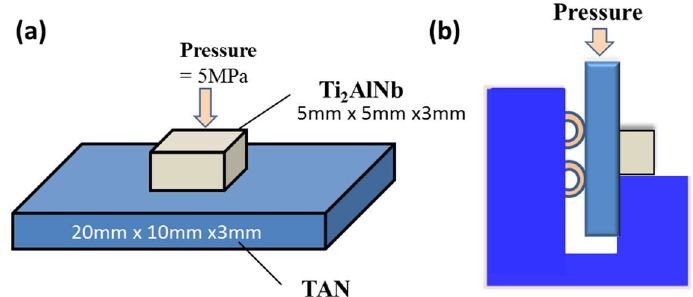
Figure 2. Schematic diagrams of ( a ) assembling diffusion bonding parts and ( b ) shear test